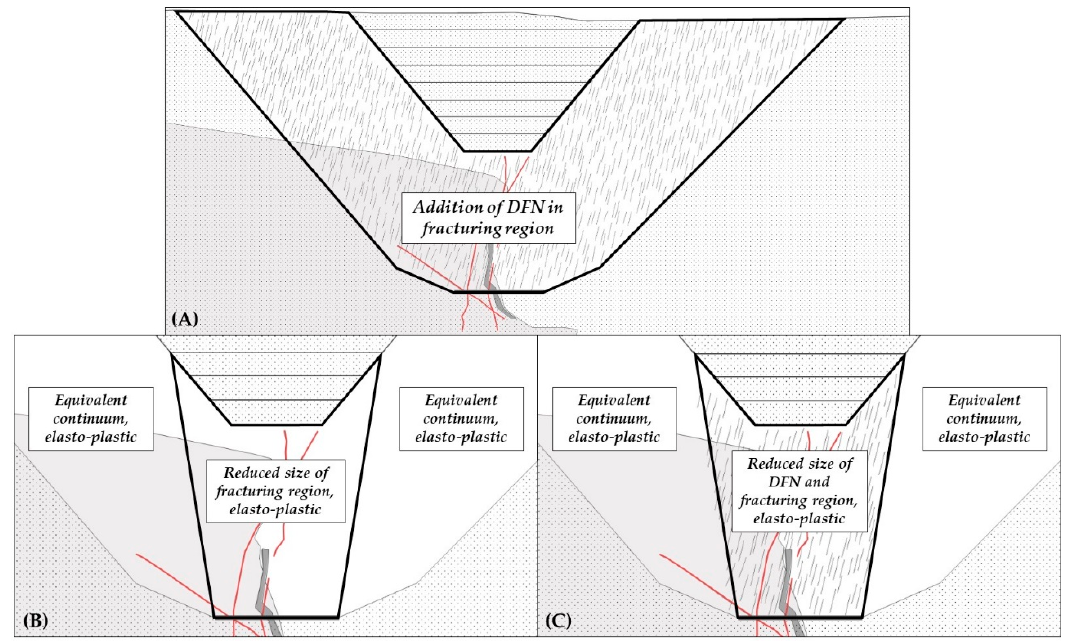
Figure 11. FDEM geometry variations for ( A ) model No. 6, ( B ) model No. 7, and ( C ) model No. 8.